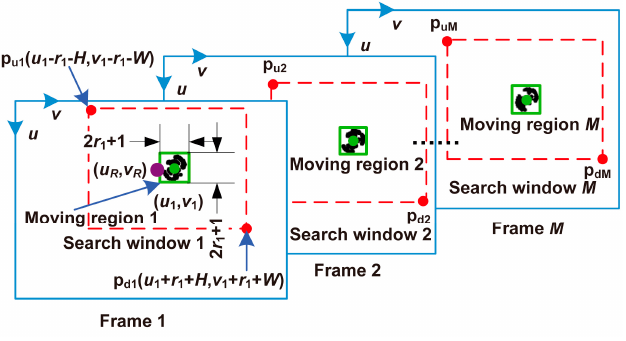
Figure 4. Illustration of the center and radius of each labeled connected component. Figure 5. Moving regions and search windows of the cell of interest. ( u R , v R ), 2 W + 1 and 2 H + 1 are the center, width, and height of the rectangular region selected in the first frame. M denotes the number of frames in the video.